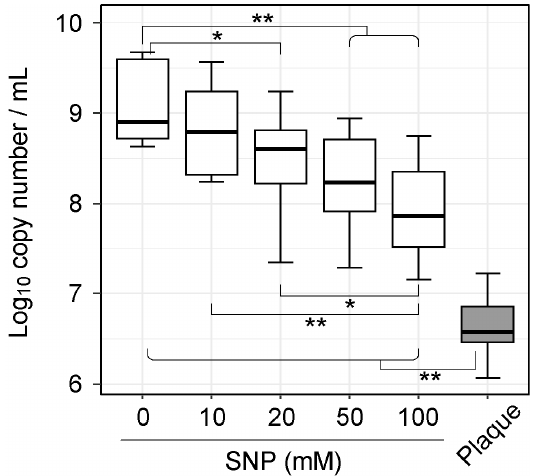
Figure 1. Total bacterial density in the initial plaque samples and in vitro cultures. For qPCR quantification, the universal bacterial 16S rRNA primers were used to estimate the concentration of total bacterial DNA. Horizontal lines indicate statistical significance according to the Wilcoxon rank-sum test (* p < 0.05, ** p <